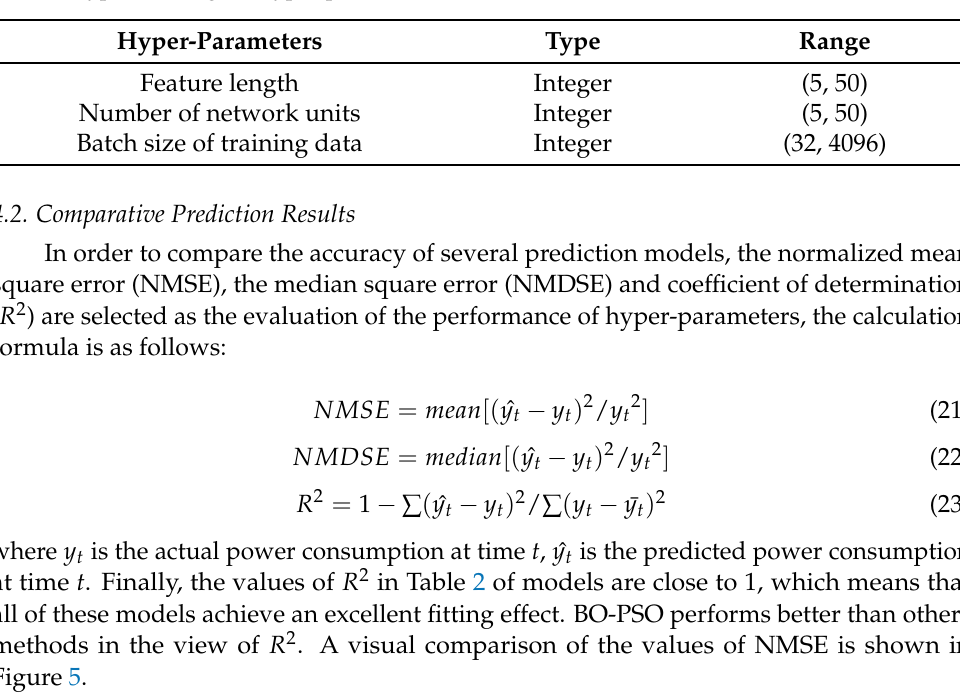
Figure 4. Flow chart of load forecasting. Table 1. Type and range of